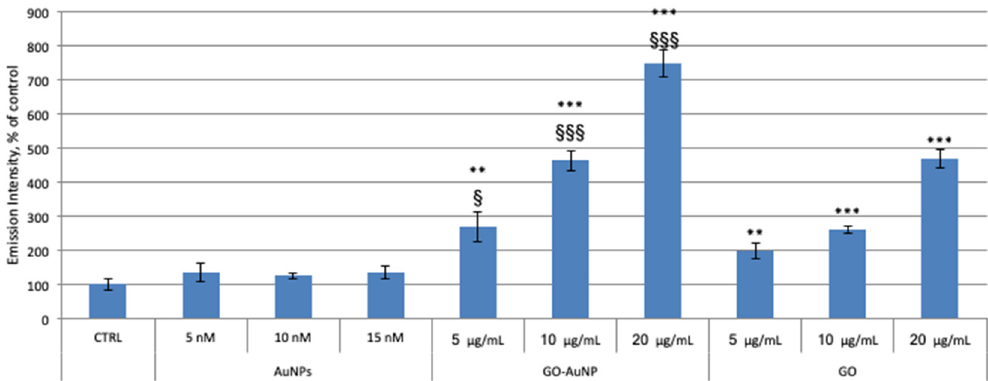
Figure 6. MitoSOX experiment on neuroblastoma SH-SY5Y cell line. Cells were incubated for 24 h with AuNPs, GO-AuNP, and free GO nanosheets, at different concentrations: 5, 10, 15 nM of AuNPs; 5, 10, 20 µ g/mL of GO into the hybrids; 5, 10, 20 µ g/mL of GO alone. Results are presented as mean ± SEM from experiments in triplicate and normalized with respect to the control untreated cells. Asterisk (**) represents the correlation significant at the p ≤ 0.01 and (***) at the p ≤ 0.001 level with respect to the control; (§) represents the correlation significant at the p ≤ 0.05 and (§§§) at the p ≤ 0.001 level with respect to the